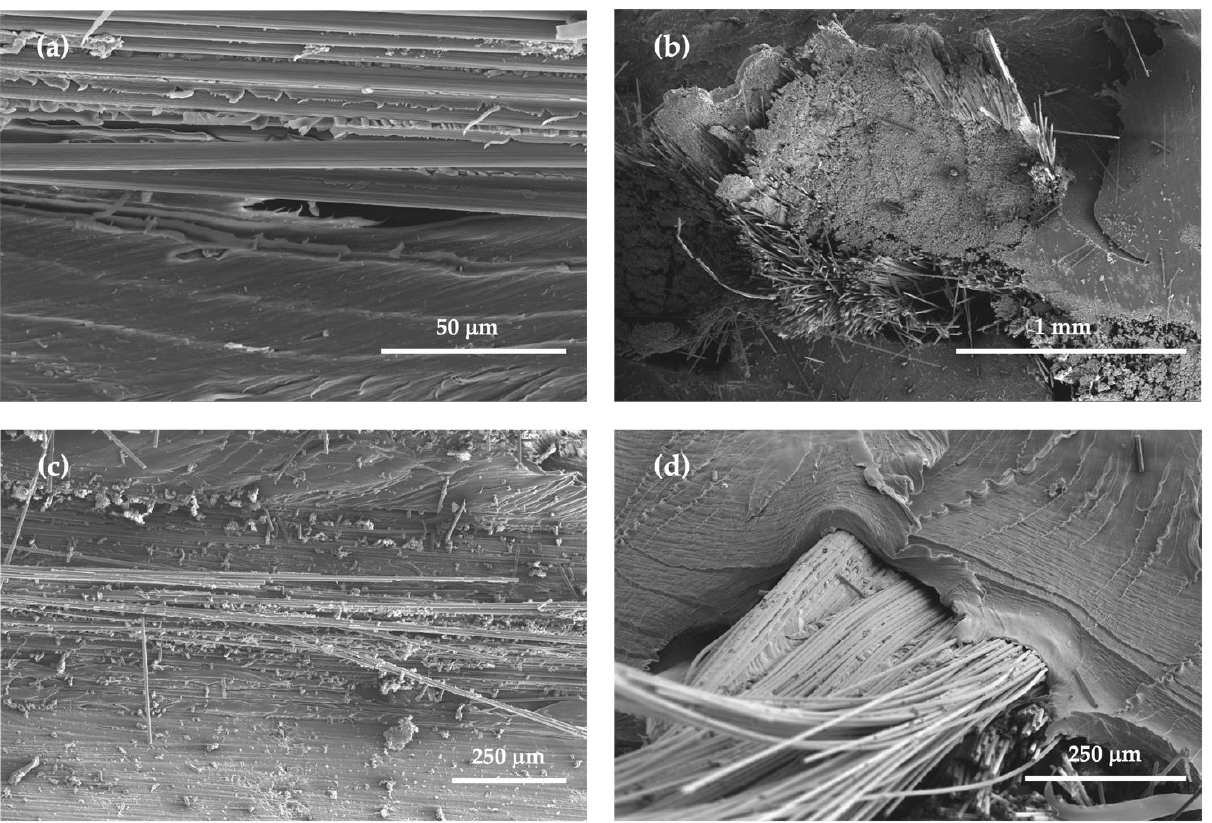
Figure 7. SEM micrographs at different magnification levels: ( a , b ) composites with untreated carbon fibers; ( c , d ) composites with LPP-treated carbon fibers.